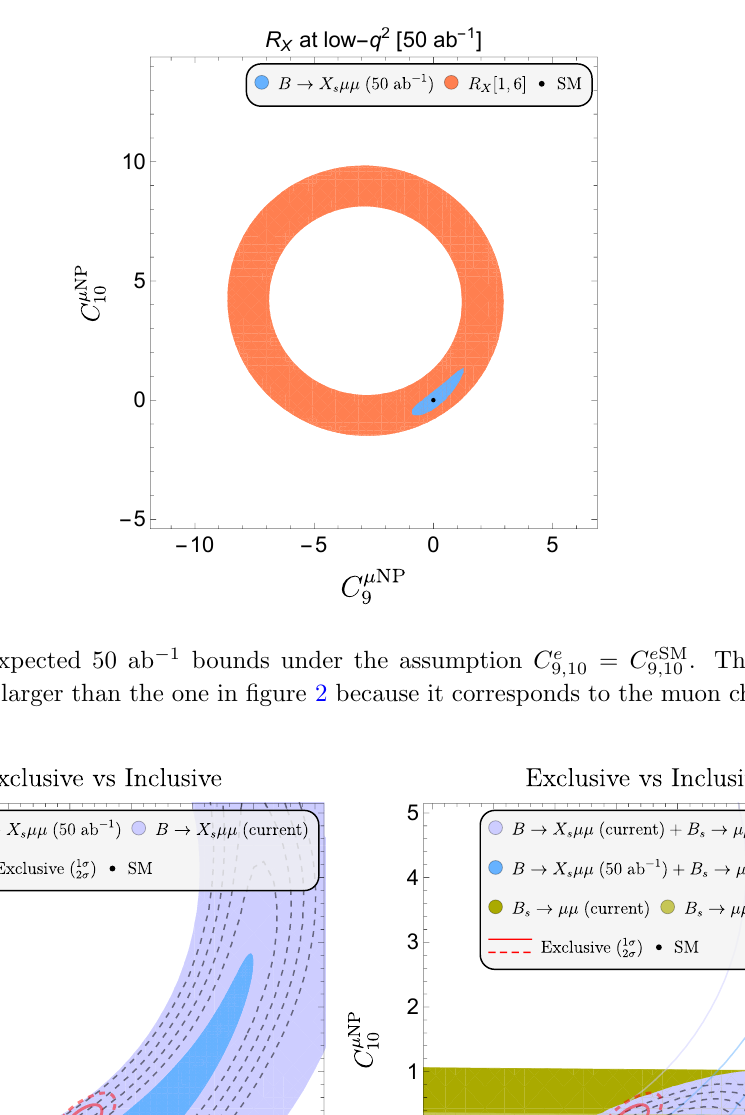
Figure 7 . Comparison between the expected bounds from inclusive measurements (up to six standard deviations) with the bounds from existing exclusive b ! s‘ + ‘ (cid:0) measurements. The latter are derived using the Flavio [80] and Smelli [81] packages and include constraints from branching ratio and asymmetries in b ! s(cid:22) + (cid:22) (cid:0) as well as from the lepton (cid:13)avour universality violating ratios R . In the right panel we combine inclusive (cid:22) B ! X s (cid:22) + (cid:22) (cid:0) with the current determination of K ( (cid:3) ) B ( (cid:22) B s ! (cid:22) + (cid:22) (cid:0) ).